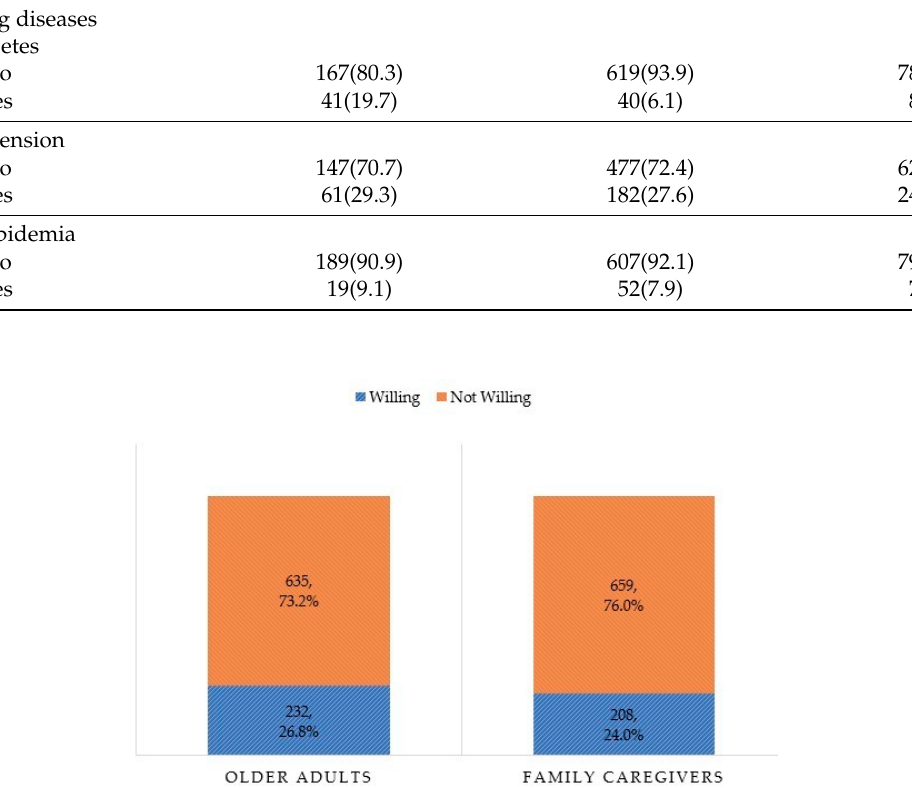
Figure 1. Willingness of study participants to use an intermediary care service at CIIC center, Maehia, Chiang Mai, Thailand 2019 .